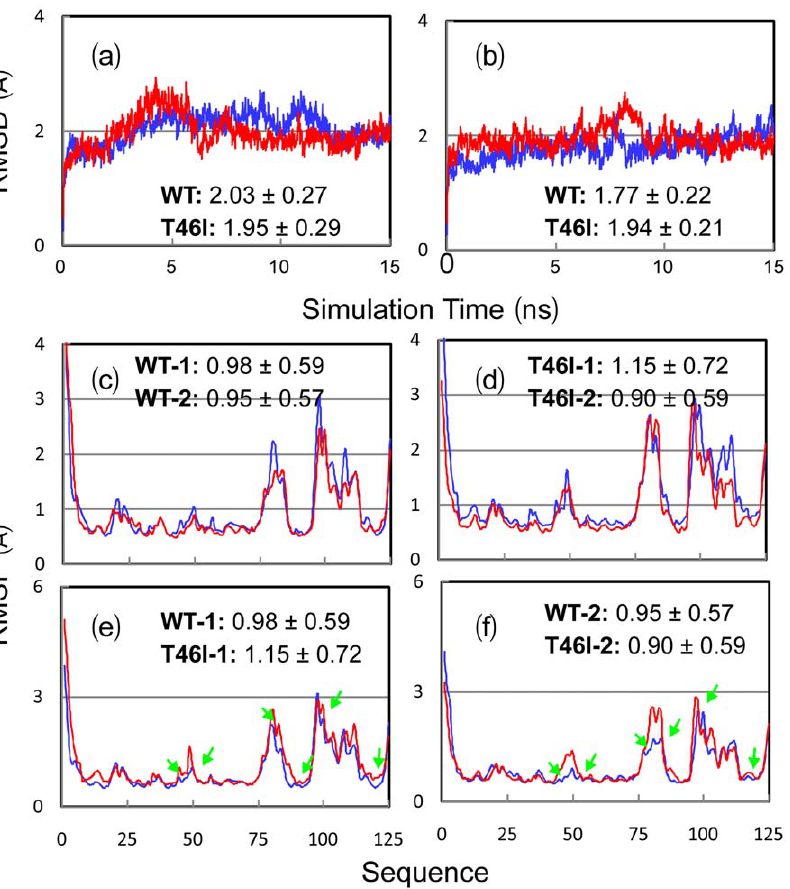
Figure 7. Trajectories of MD simulations. (a–b). Root-mean-square deviations (RMSD) of the backbone atoms for two independent MD simulations of the WT- (blue) and T46I- (red) MSP domains. (c–d). Root-mean-square fluctuations (RMSF) of the C a atoms computed for two independent simulations (blue for simulation 1 and red for simulation 2) of the WT- (c) and T46I- (d) MSP domains. (e–f). Root-mean-square fluctuations (RMSF) of the C a atoms computed for two independent simulations for the WT- (blue) and T46I- (red) MSP domains. The average values and standard deviations over 15 ns are computed and displayed. The green arrows are used to indicate the T46I-MSP residues with fluctuations larger than those of the WT-MSP